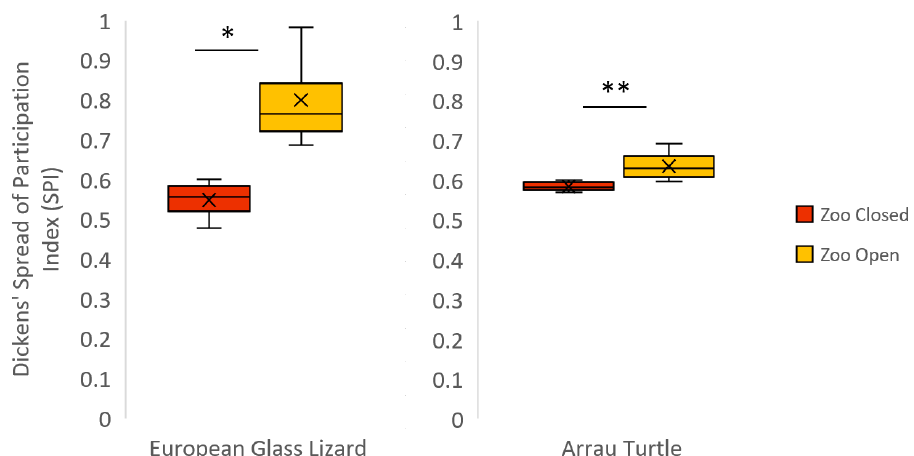
Figure 3. Boxplot for all significant differences within a species in the Dickens’ Spread of Participation Index (SPI) when the zoo was closed vs. open. For SPI, lower values mean more even space use. The mean of each condition is represented by an “ × ” and all outliers are indicated by circles. Significant differences (Pr > |S-Mean| below 0.05) are indicated with an asterisk (*), and Pr > |S-Mean| of 0.01 or below are indicated with a double asterisk (**).